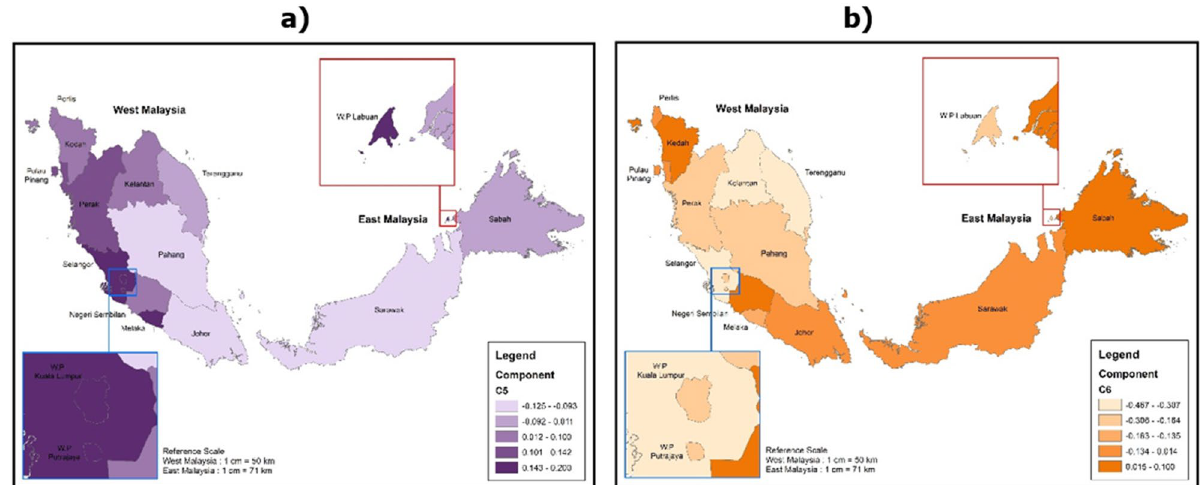
Figure 4. Challenges of e-learning from the aspect of social isolation and low digital literacy (the images were generated and modified from open source ‘Malaysia—Subnational Administrative Boundaries’ (https:// data. humda ta. org/ datas et/ cod- ab- mys) using ArcGIS Desktop 10.8.1 (https:// www. esri. com/ en- us/ arcgis/ produ cts/ arcgis- deskt op/ overv